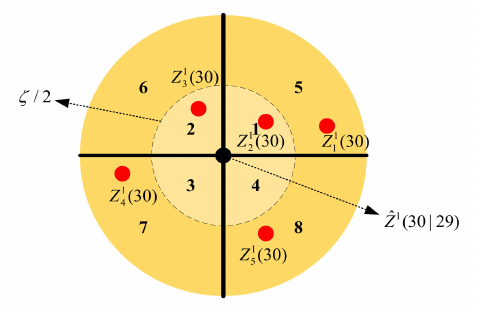
Figure 3. Example of the first target with five candidate measurements.